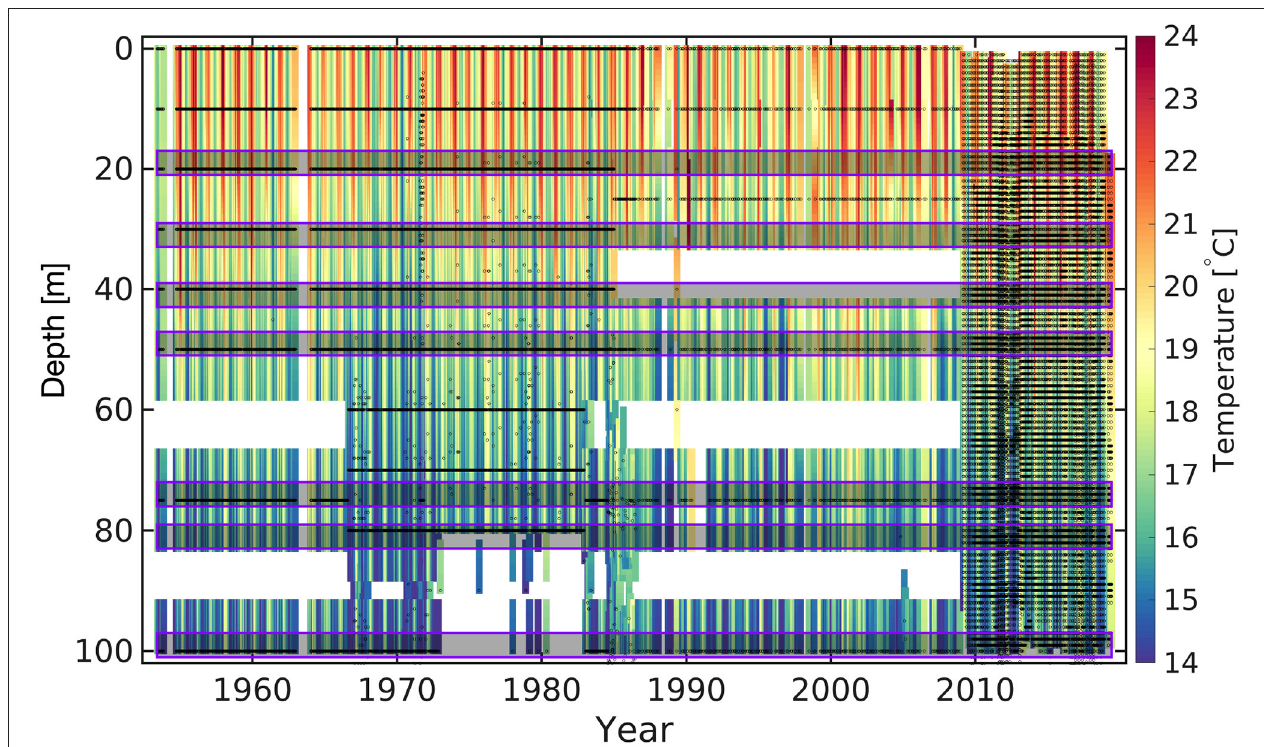
FIGURE 5 | Interpolated daily temperatures with 1m vertical spacing at the Port Hacking site between 1953 and 2019. The black circles represent the depths and times of non-interpolated temperature observations, whilst the transparent gray boxes with purple outlines represent the 1 ± 2m depth bins used to produce the